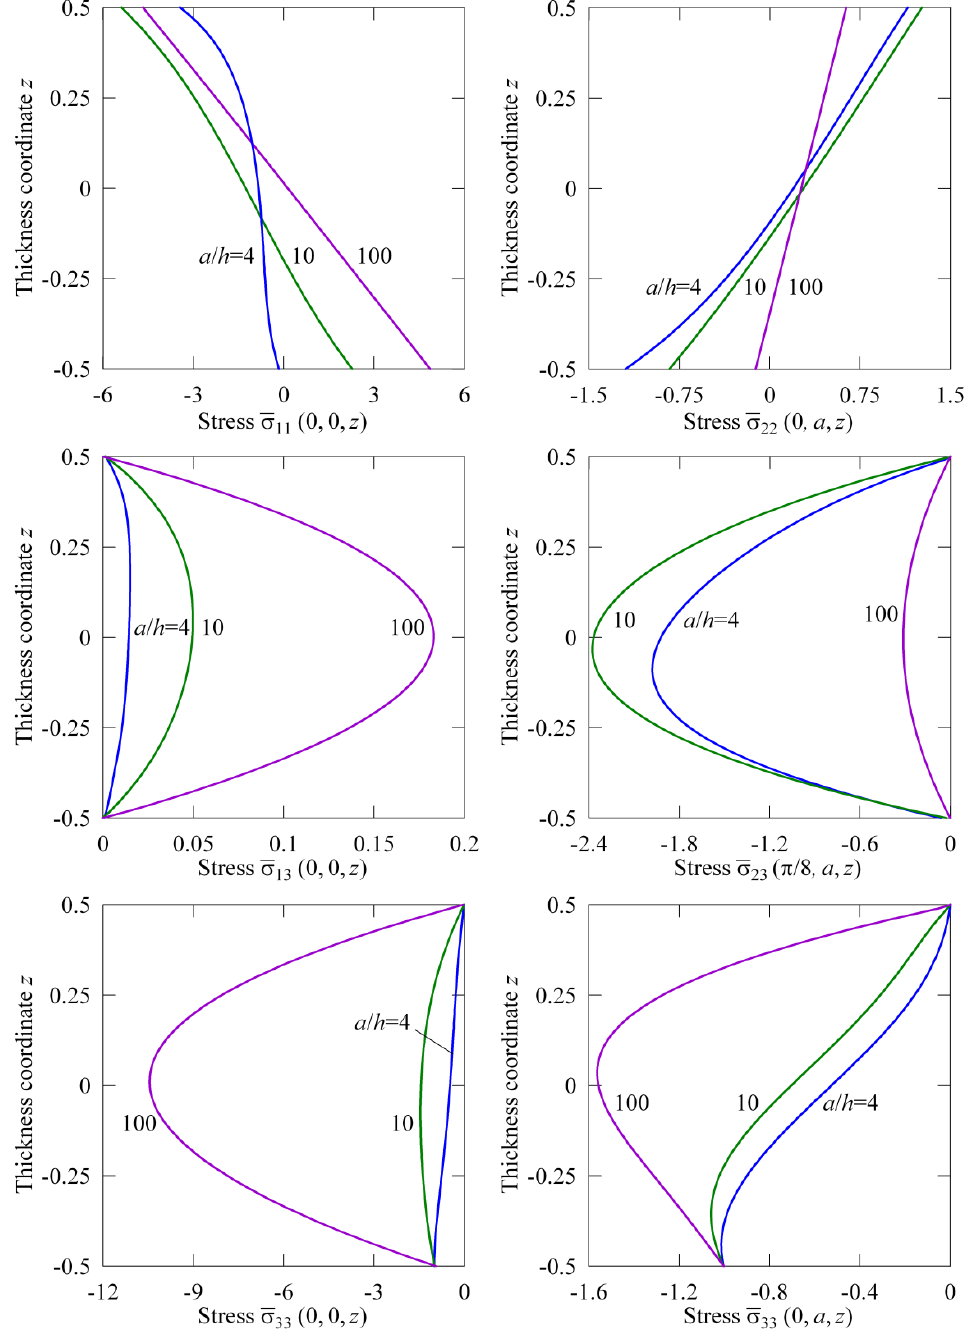
Figure 11: Through-thickness distributions of stresses for a hyperbolic composite shell with seven SaS using a regular 64 × 64 mesh of SaSGeX4 elements.